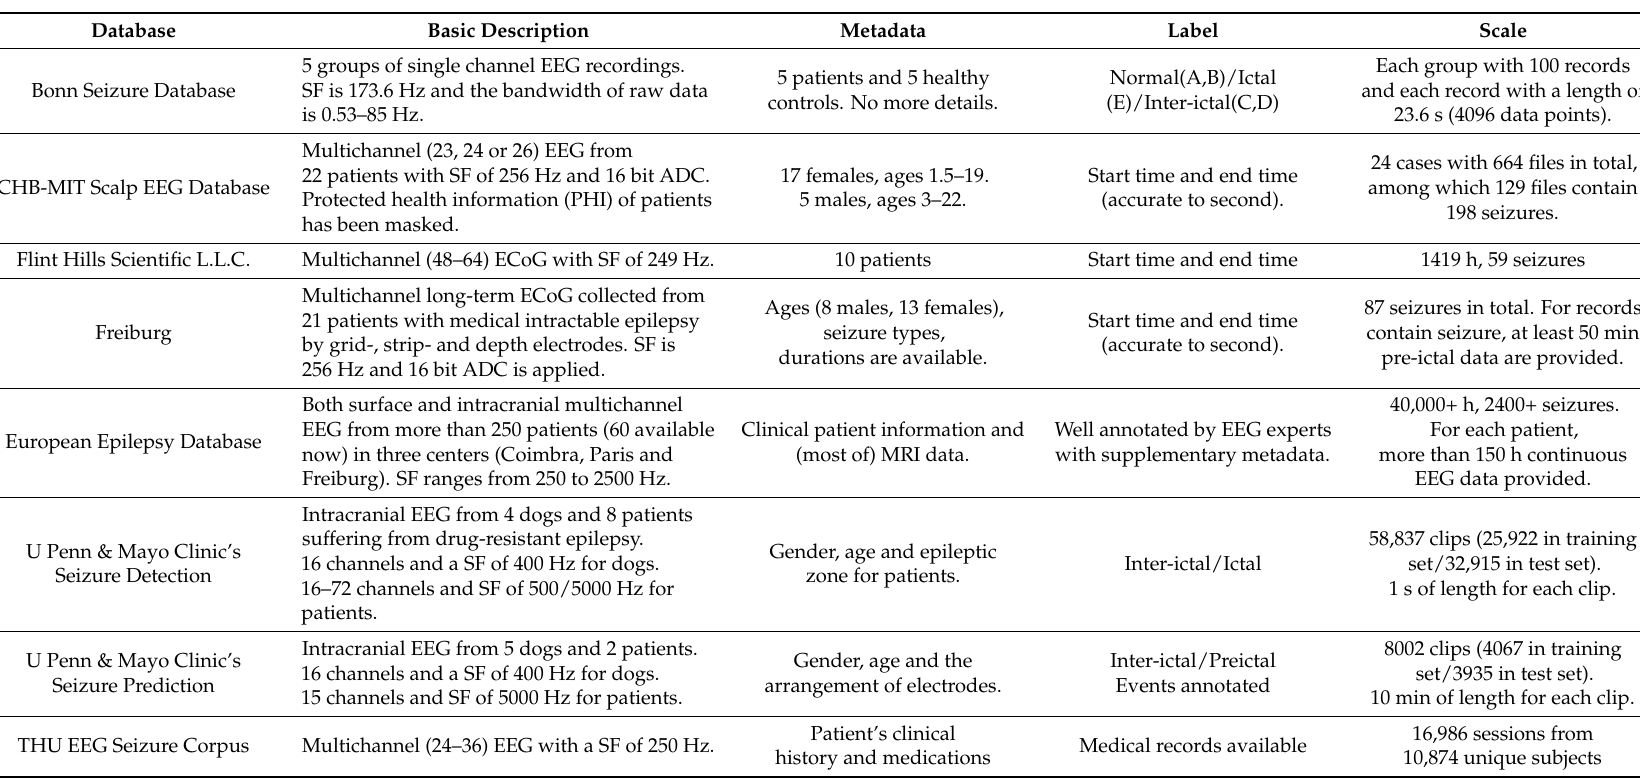
Table 4. Public-available datasets for the research about automatic seizure monitoring (SF: sampling frequency. ADC: analog-to-digit converter. ECoG: